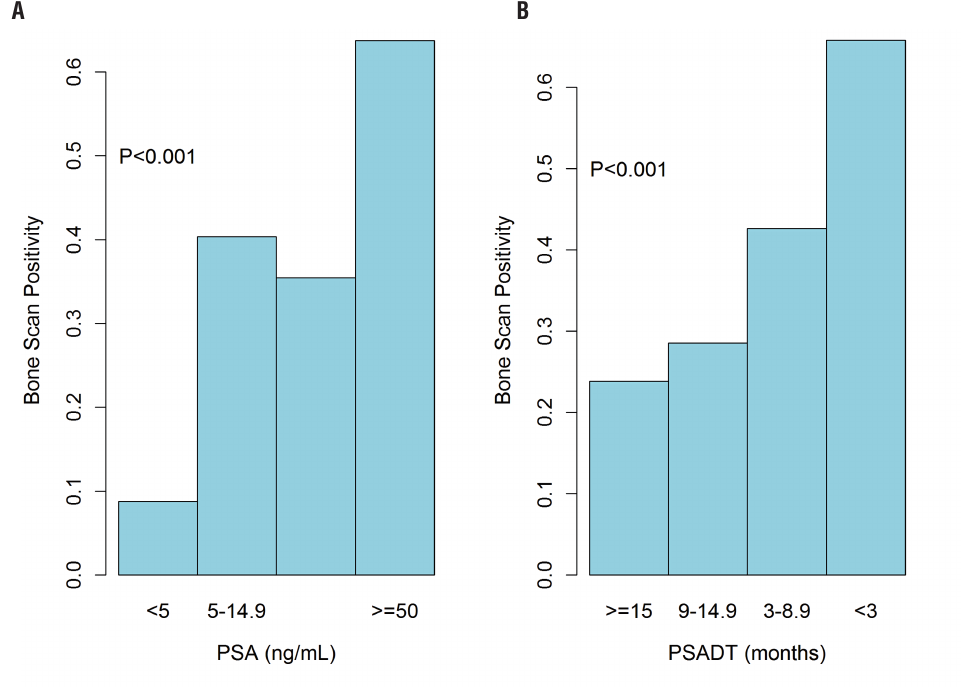
Figure 2 - Bone scan positivity by PSA (A) and by PSA doubling time (B).